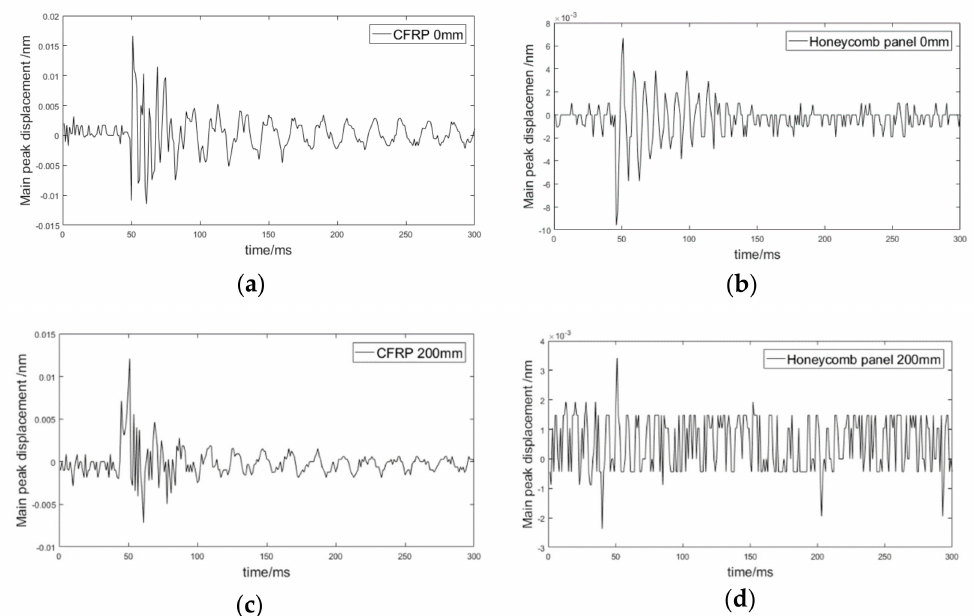
Figure 4. Time-domain response signals of the sandwich panel and carbon-fiber reinforced polymer (CFRP) laminate: ( a ) CFRP with sensor 0 mm from impact position; ( b ) honeycomb panel with sensor 0 mm from impact position; ( c ) CFRP with sensor 200 mm from impact position; ( d ) honeycomb panel with sensor 200 mm from impact position.